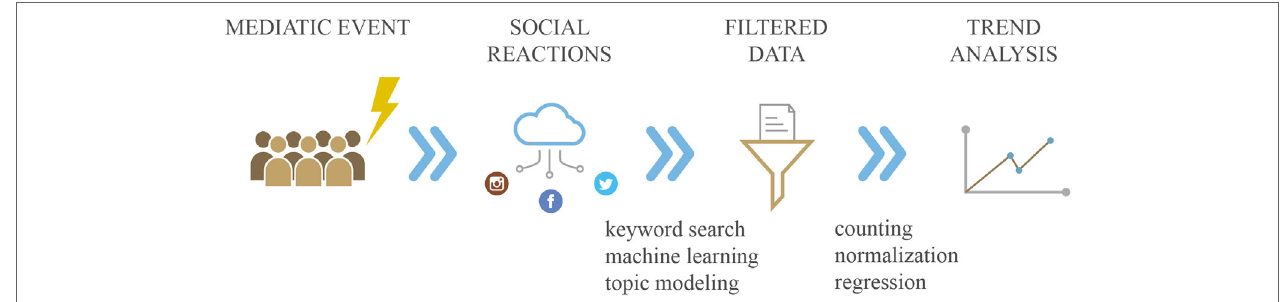
FigURe 1 | Collection and analysis of health-related demand data generated by novel data streams. Example of media event influencing society and consequent social reactions caught by social networks. Analysis of these data is represented by trend report.